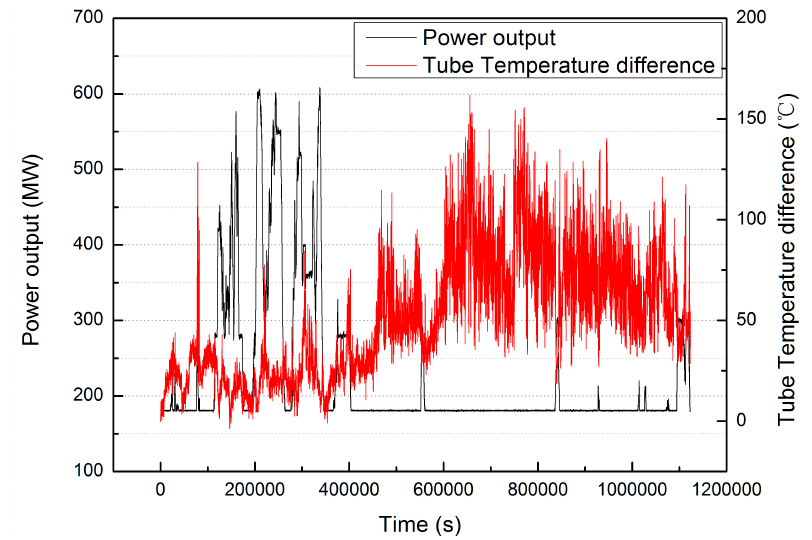
Figure 7. Load and tube temperature difference vs. time at the highest tube temperature difference point.